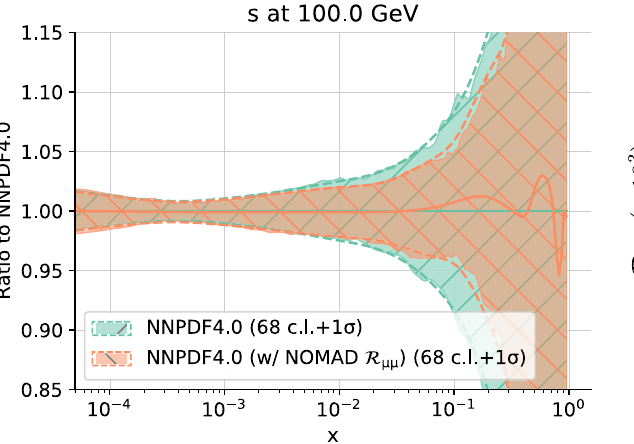
ison for the measured ratio R μμ as a function of the neutrino energy E ν . The inset displays quantities normalized to the central experimental value